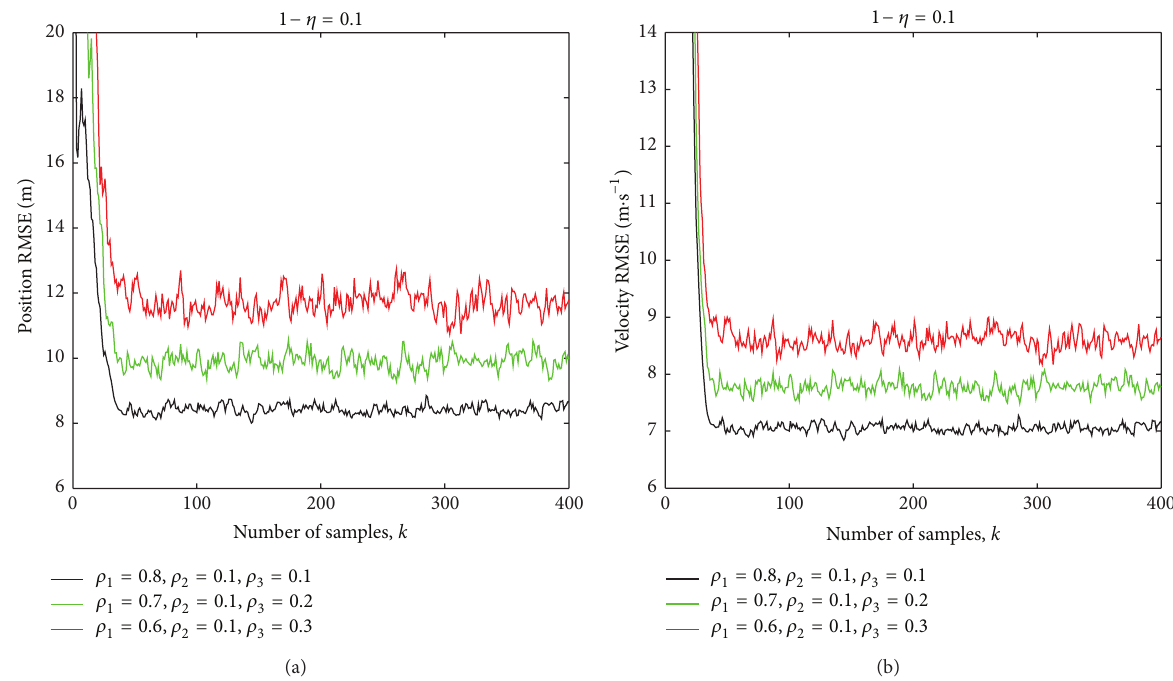
Figure 9: Comparison of the RMSEs for the proposed algorithm with different 𝜌 𝑞 (𝑞 = 1,2, 3) : (a) position RMSE; (b) velocity RMSE.